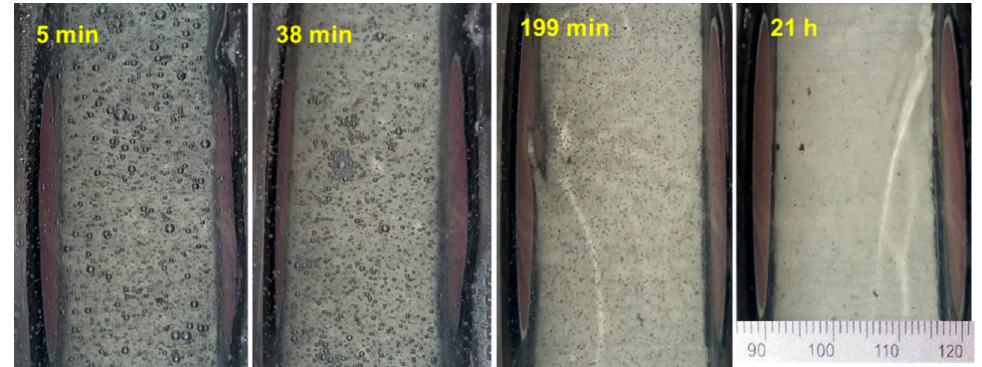
Figure 2. Photographs of the bubbles pattern in the shampoo for different times.